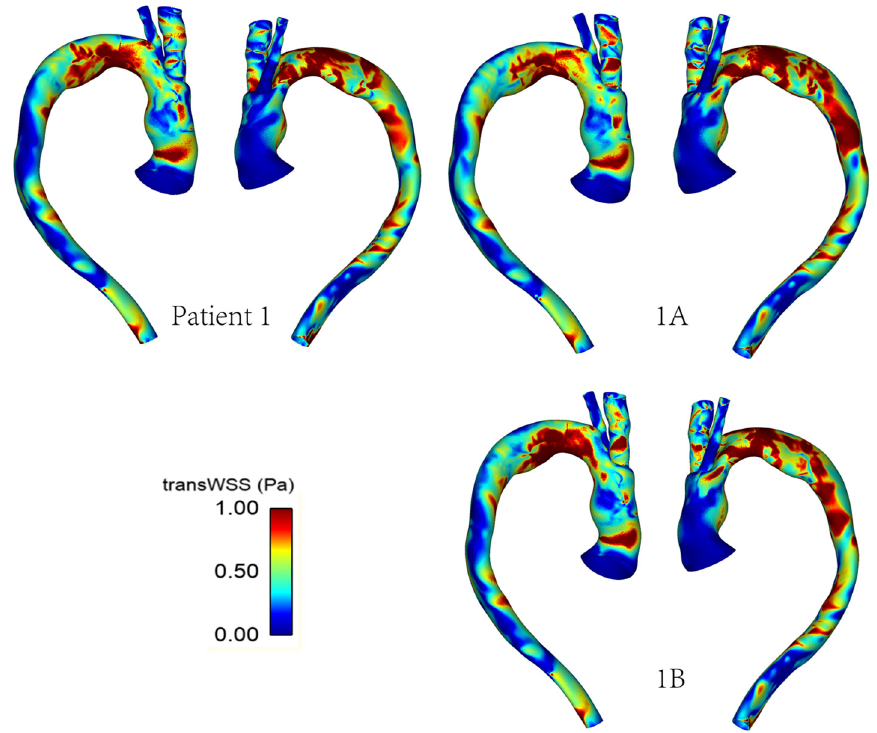
Figure 10. transWSS distribution in the repaired aorta of Patient 1 with different tunnel branch diameters (1–12 mm, 1A–10 mm, 1B–8 mm).